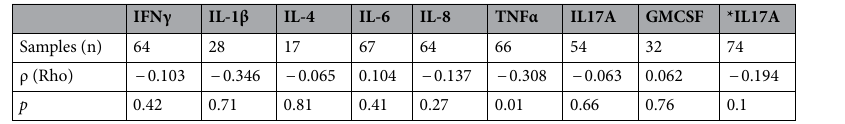
Table 6. Correlation between sample age and analyte concentration. In this table, we measured correlation using Spearman’s rank correlation (Rho) ρ bivariate analysis of sample age and each individual concentration of analyte per sample. Number of samples analysed (n) per analyte. Statistical significance is considered when p value < 0.05. *analyte measured using ultra-sensitive MSD